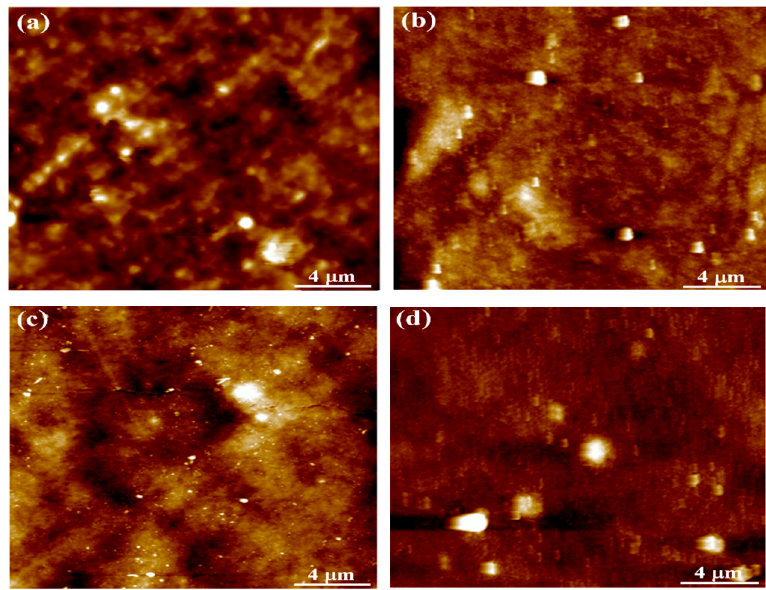
Figure 9. AFM height images of the surface of PLA and its biocomposites: ( a ) PLA, ( b ) PLA/Ac-lignin, ( c ) PLA/At-lignin, ( d ) PLA/By-lignin.